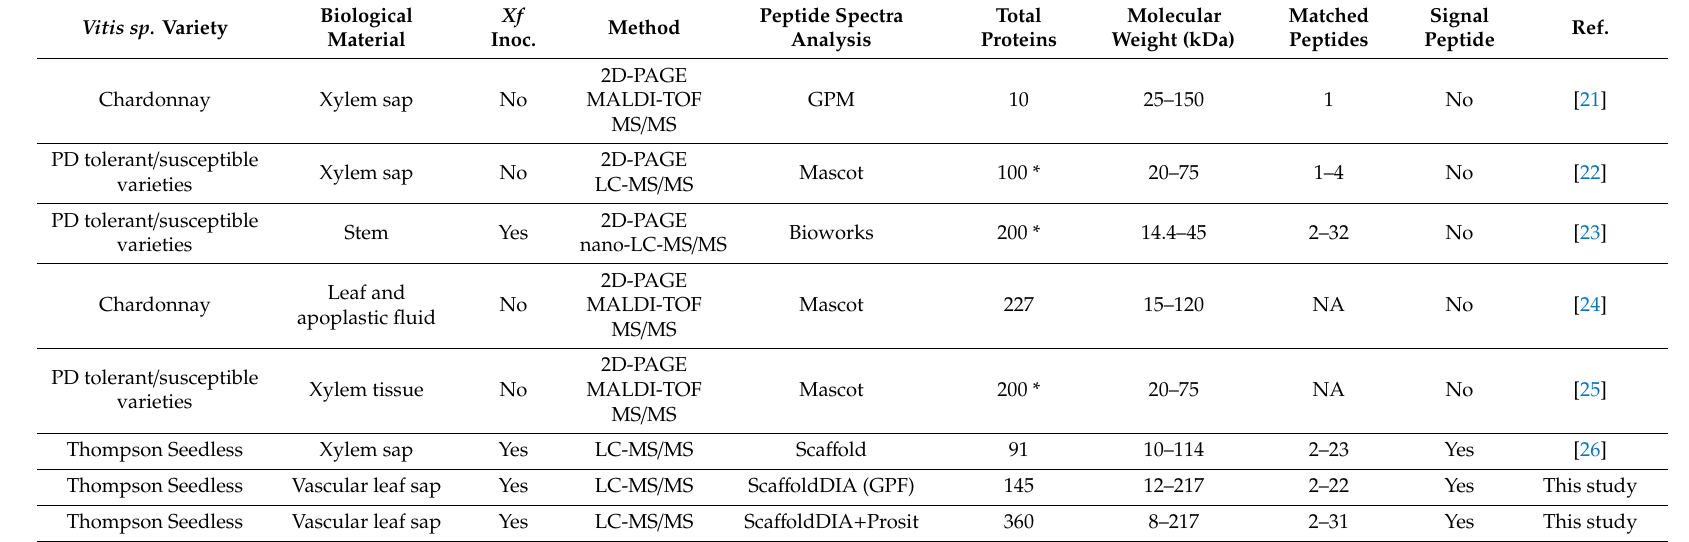
Table 1. Overview of proteomics studies of grapevine vascular